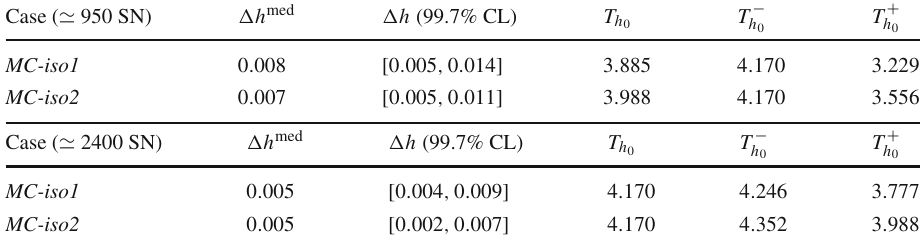
Table 2 Respectively: Same as Table 1, but for 200 MCs assuming 4 and 10 times more data points than the current sample